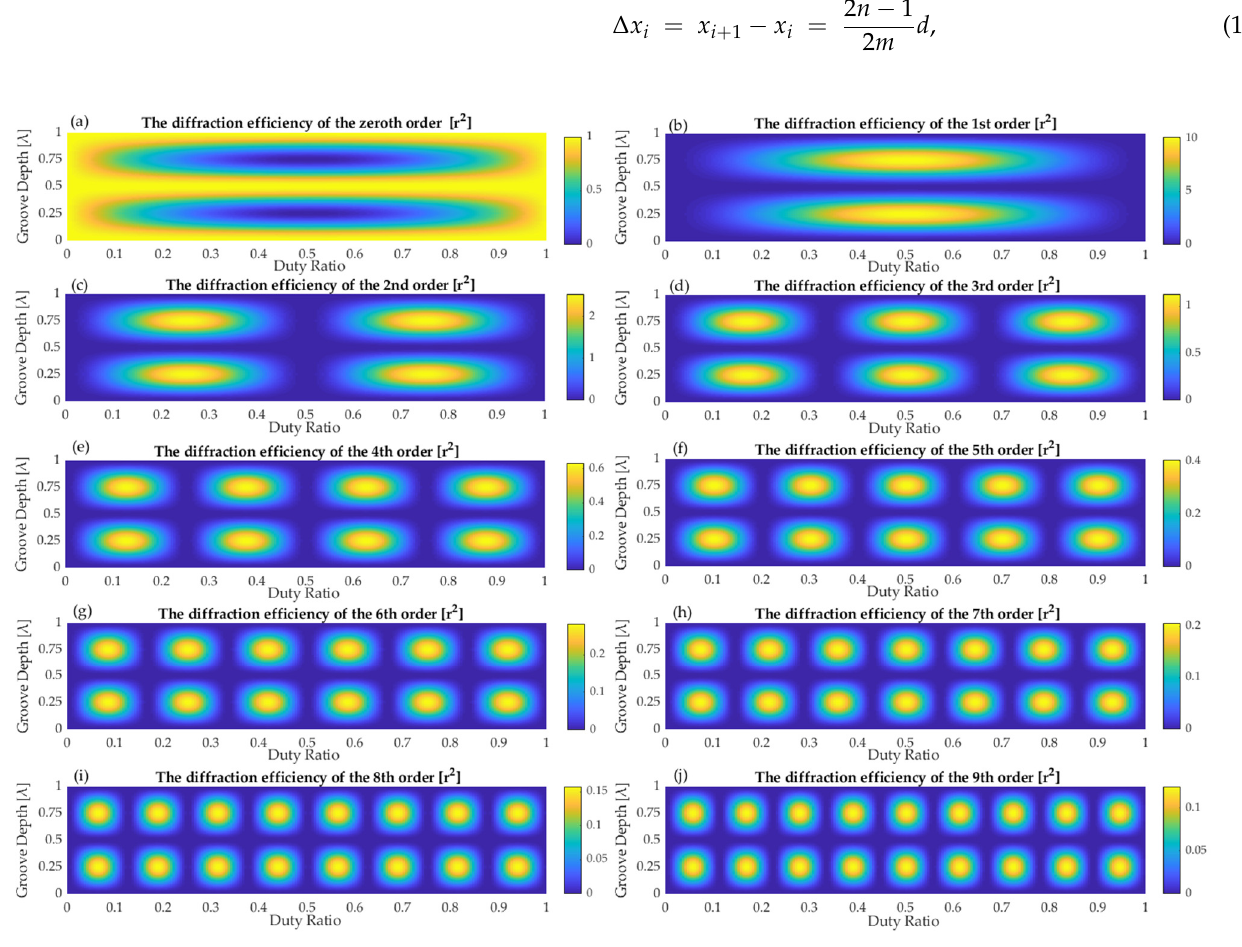
Figure 5. Diffraction efficiency of standard grating as a function of duty cycle and groove depth at diffraction orders from 0 to 9.